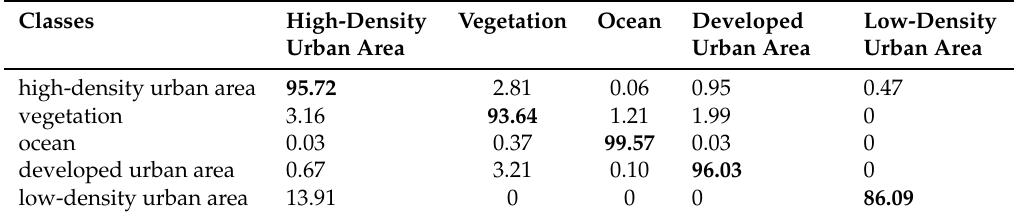
Table 7. Confusion matrix (%, category accuracy is shown in bold) of TSNE-FCN+SVM algorithm on San Francisco